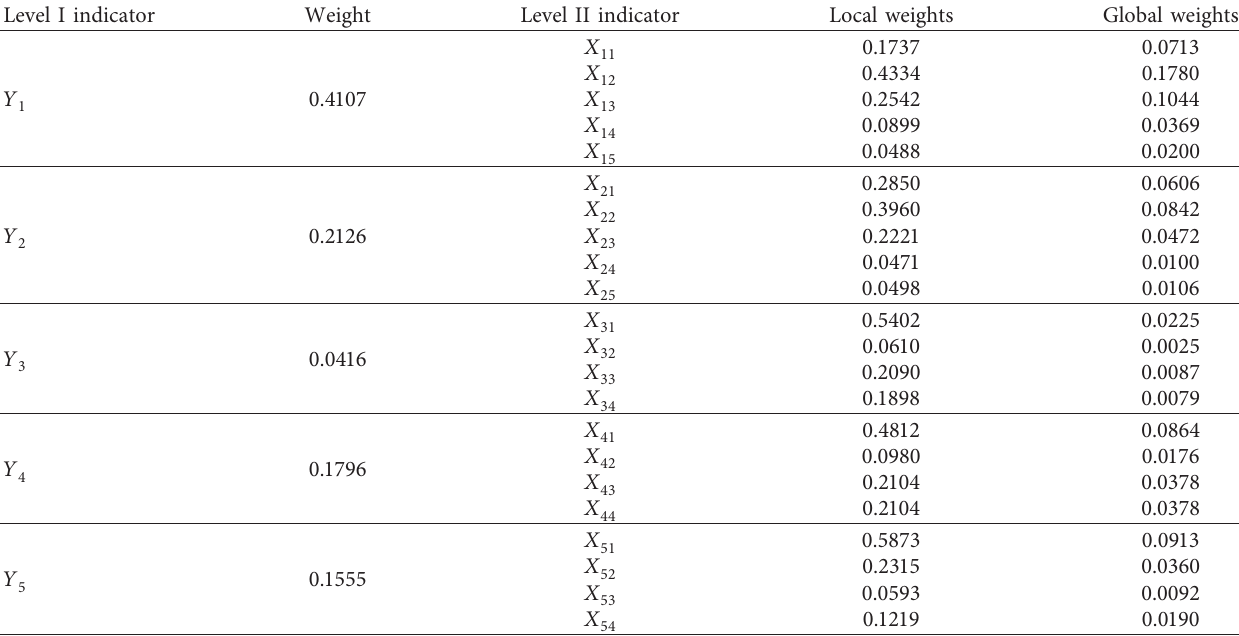
Table 10: Evaluation system and weight of indicators at all levels of the cost of prefabricated decoration.